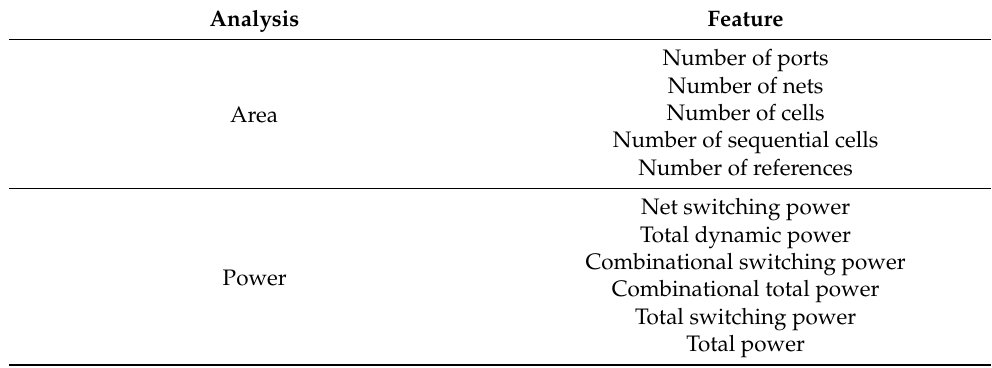
Table 1. Table with our eleven area and power analysis